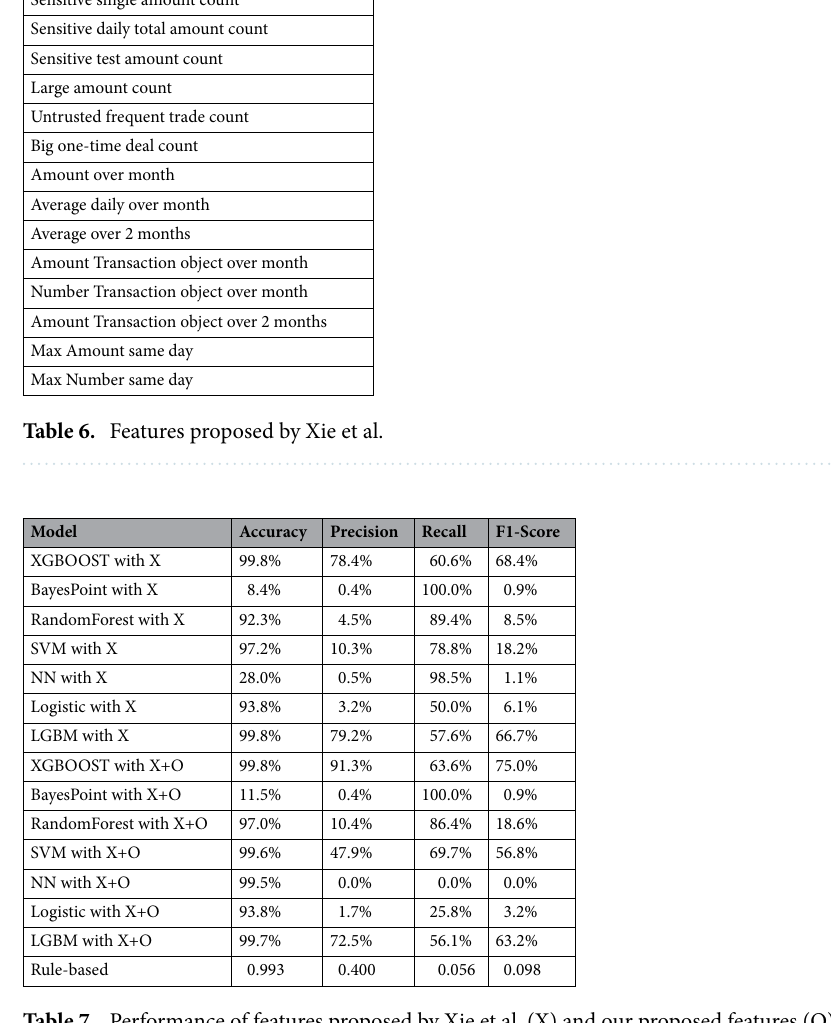
Table 7. Performance of features proposed by Xie et al. (X) and our proposed features (O).